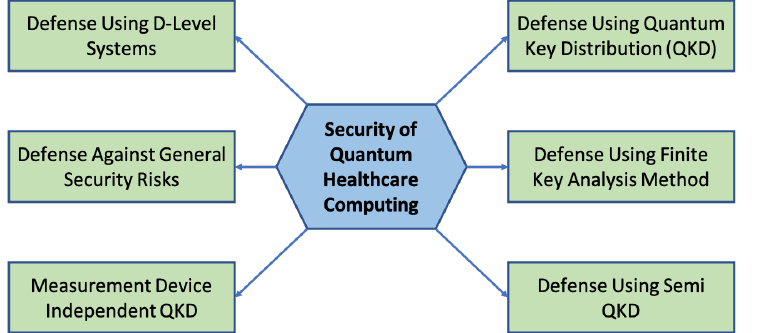
Figure 6. Taxonomy of key technologies that can ensure security for healthcare information processing using quantum